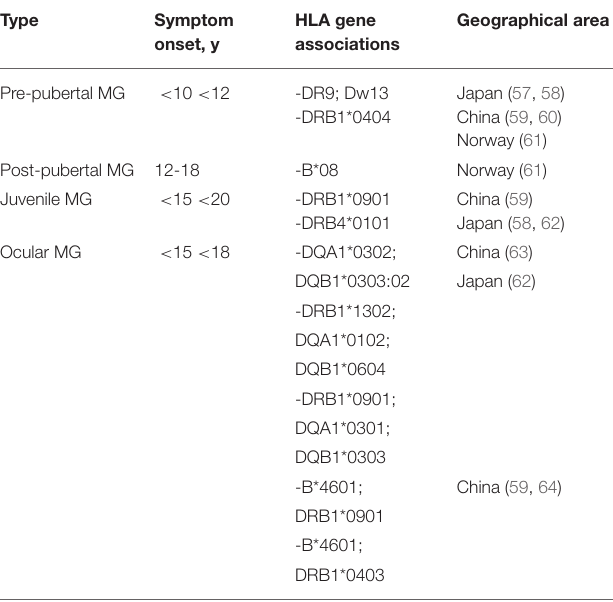
TABLE 3 | Human leukocyte antigen (HLA) associations in juvenile myasthenia gravis by racial ancestry or geographical